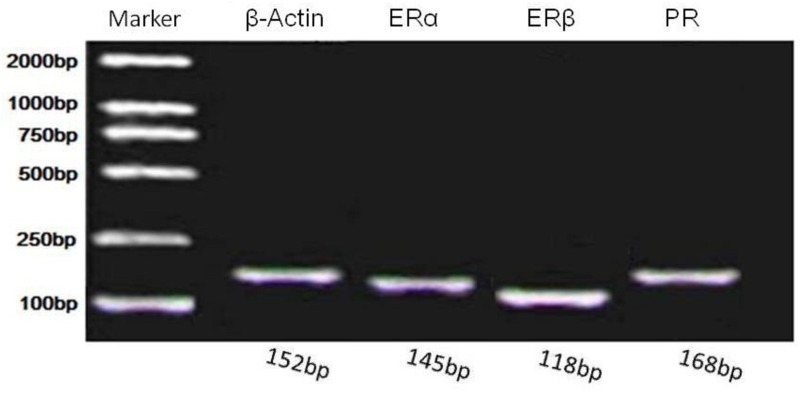
Gel image of PR, ERα and ERβ real time PCR products.